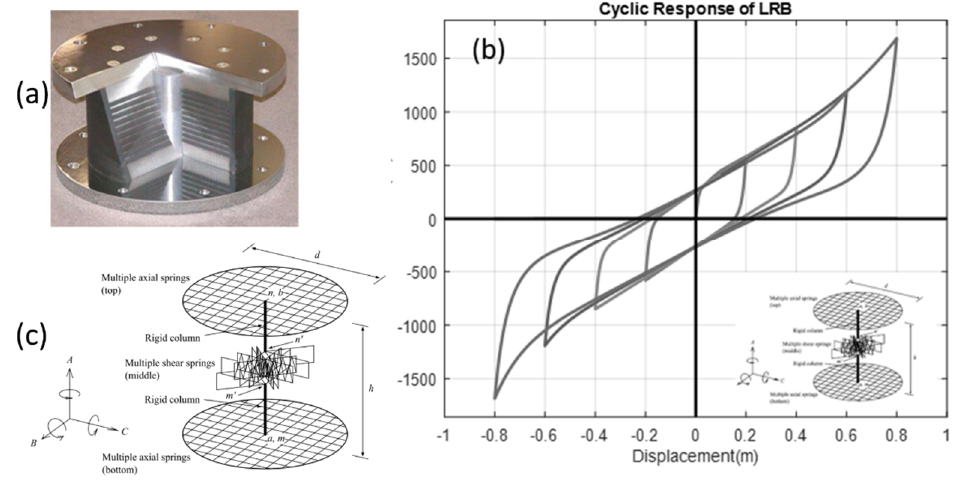
Figure 6. ( a ) A cut-away view of LRB (Courtesy of DIS) ( b ) cyclic stiffening force-deformation response under unidirectional loading ( c ) multi-spring model of lead rubber bearing